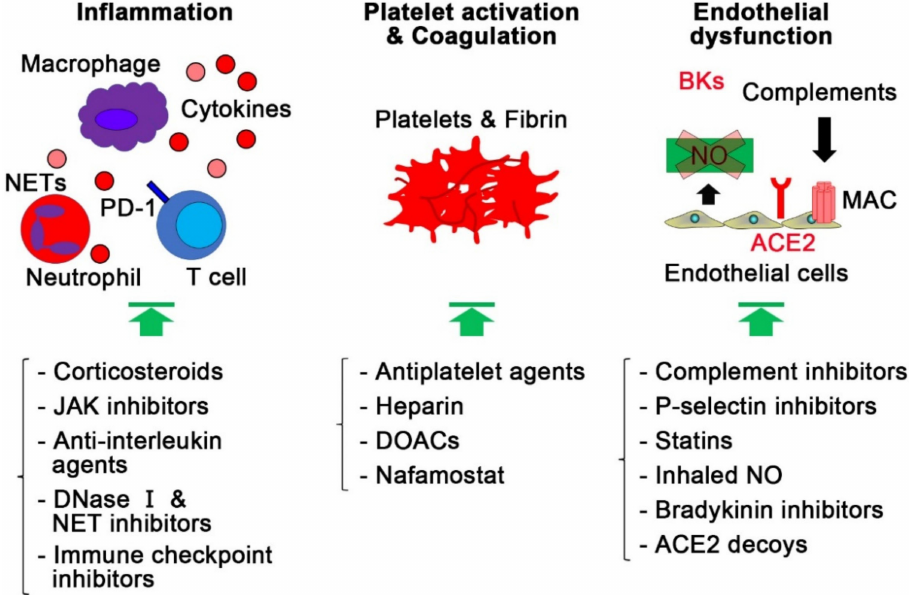
Figure 5. Therapeutic strategies targeting thromboinflammation and endothelial injury in COVID-19. In addition to vaccines or antiviral agents, therapeutic strategies, targeting inflammation,